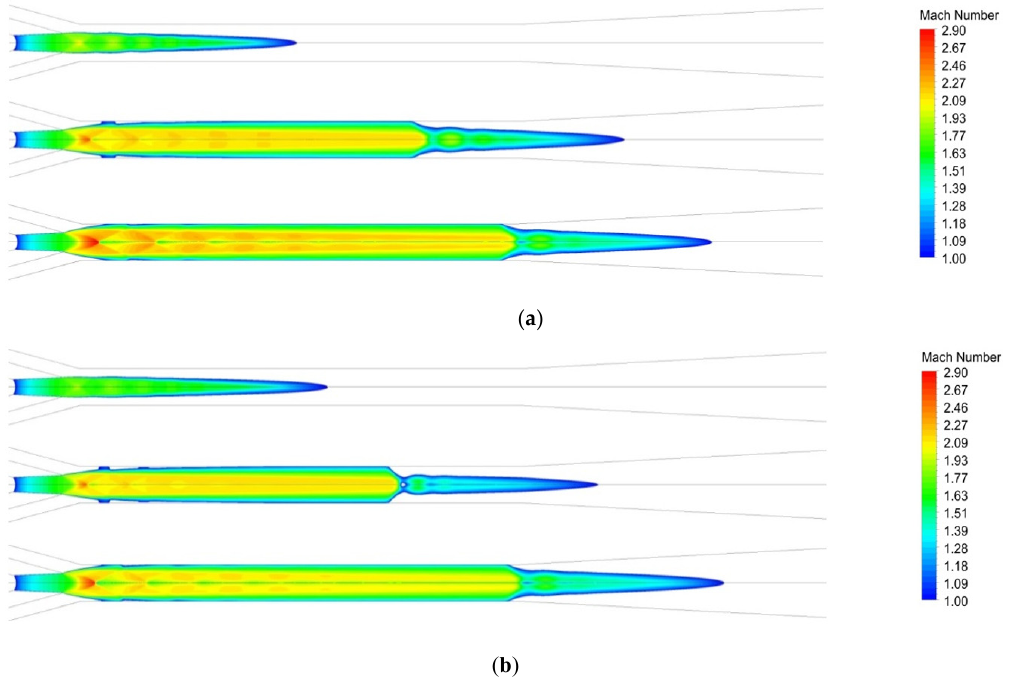
Figure 6. Mach number contours inside ejector baseline given T p = 70, 80, 87 ◦ C respectively from top to bottom for ( a ) R1234ze(E) at T s = 10 ◦ C, P c = 560 kPa. ( b ) R1234yf at T s = 10 ◦ C, P c = 730 kPa.